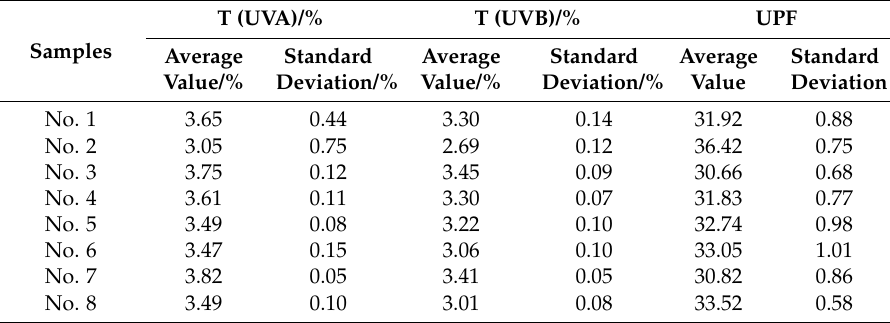
Table 2. Anti-ultraviolet property of the samples coated with Al/TiO 2 composite